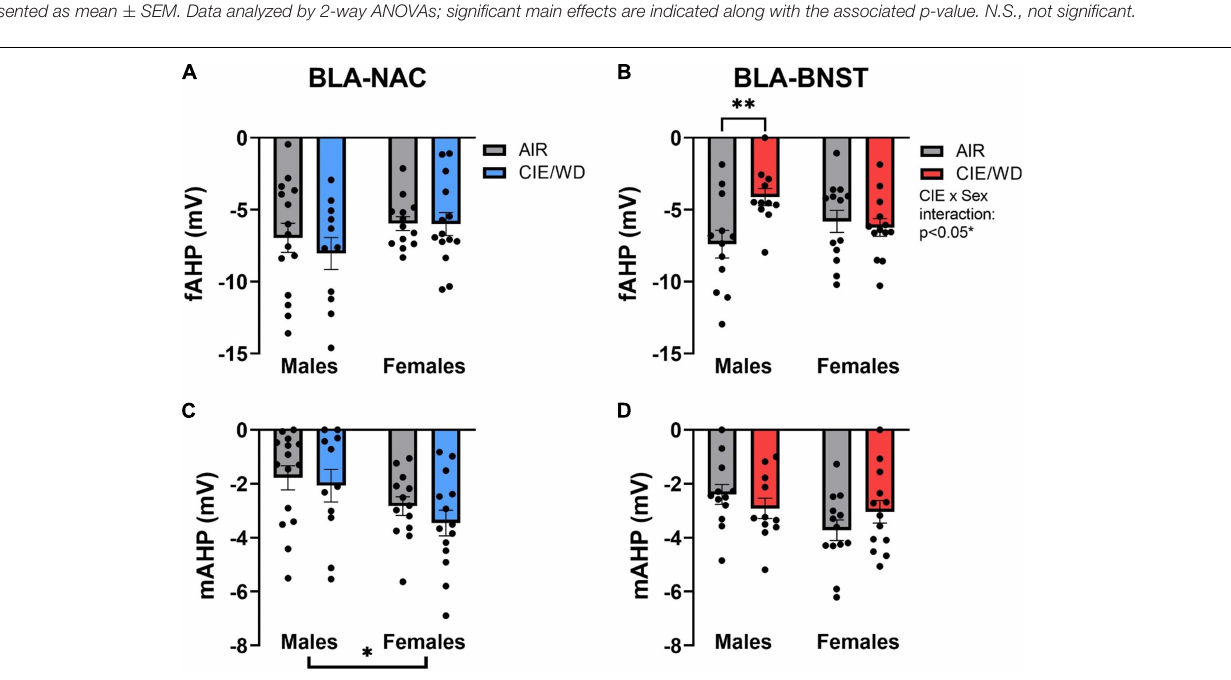
FIGURE 7 | Ethanol-induced and sex-dependent effects on afterhyperpolarization in BLA neurons. (A) CIE/WD did not alter the fAHP amplitude in BLA-NAC neurons (Males: n = 15 AIR, 11 CIE/WD; Females: n = 13 AIR, 14 CIE/WD). (B) CIE/WD reduced the fAHP amplitude only in male BLA-BNST neurons (Males: n = 12 AIR, 11 CIE/WD; Females: n = 13 AIR, 14 CIE/WD). (C) Female BLA-NAC neurons had a larger mAHP amplitude compared to males (Males: n = 15 AIR, 11 CIE/WD; Females: n = 13 AIR, 14 CIE/WD). (D) CIE/WD did not alter the mAHP amplitude in BLA-BNST neurons (trending sex effect p = 0.0688) (Males: n = 12 AIR, 11 CIE/WD; Females: n = 13 AIR, 14 CIE/WD). Data analyzed by 2-way ANOVAs. ∗∗ p < 0.01, ∗ p <